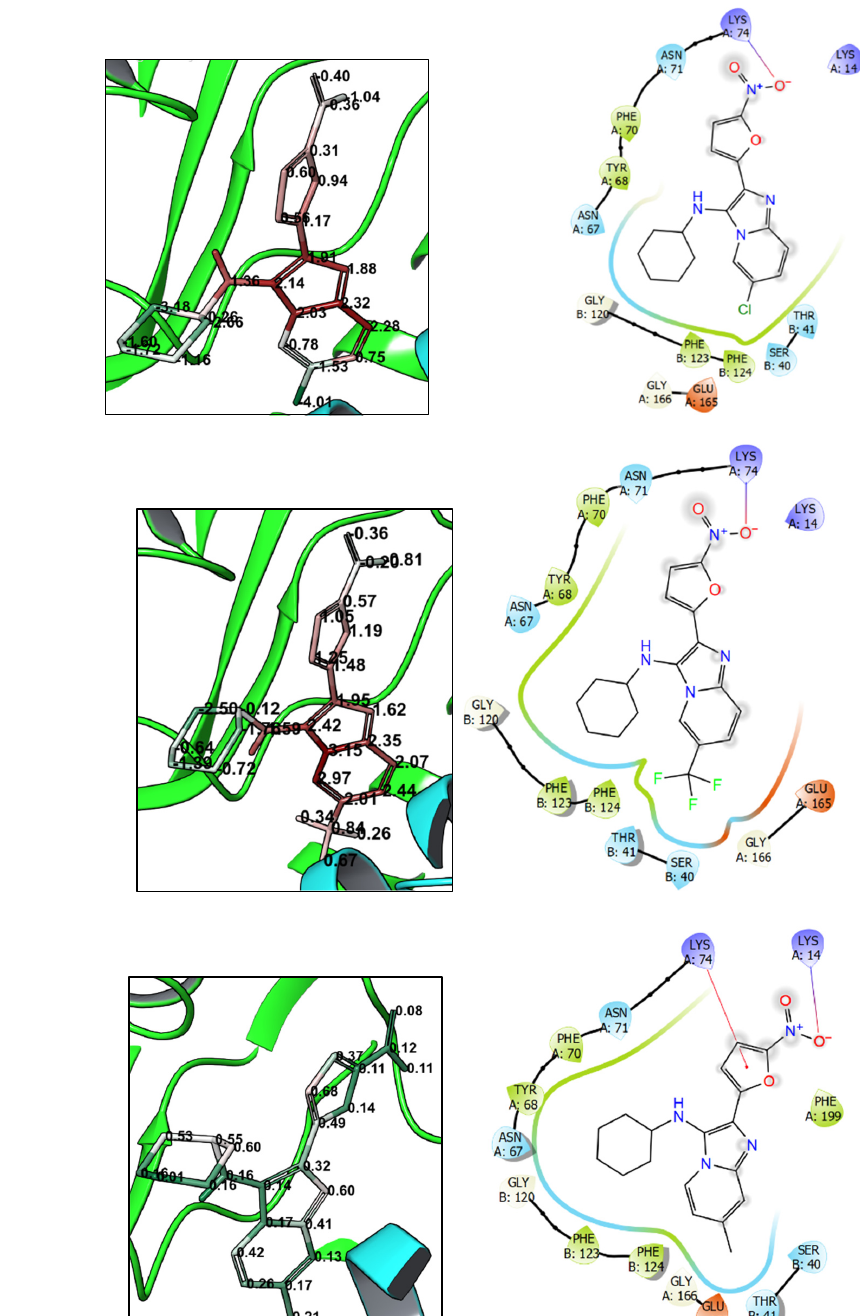
Figure 4. Strain energies and interaction diagrams of compounds 4a ( A ), 4b ( B ), 4c ( C ), and 4d ( D ) that were docked into the structure of E. coli nitroreductase NfsB (PDB 1YKI) using the flexible docking pro- tocol.